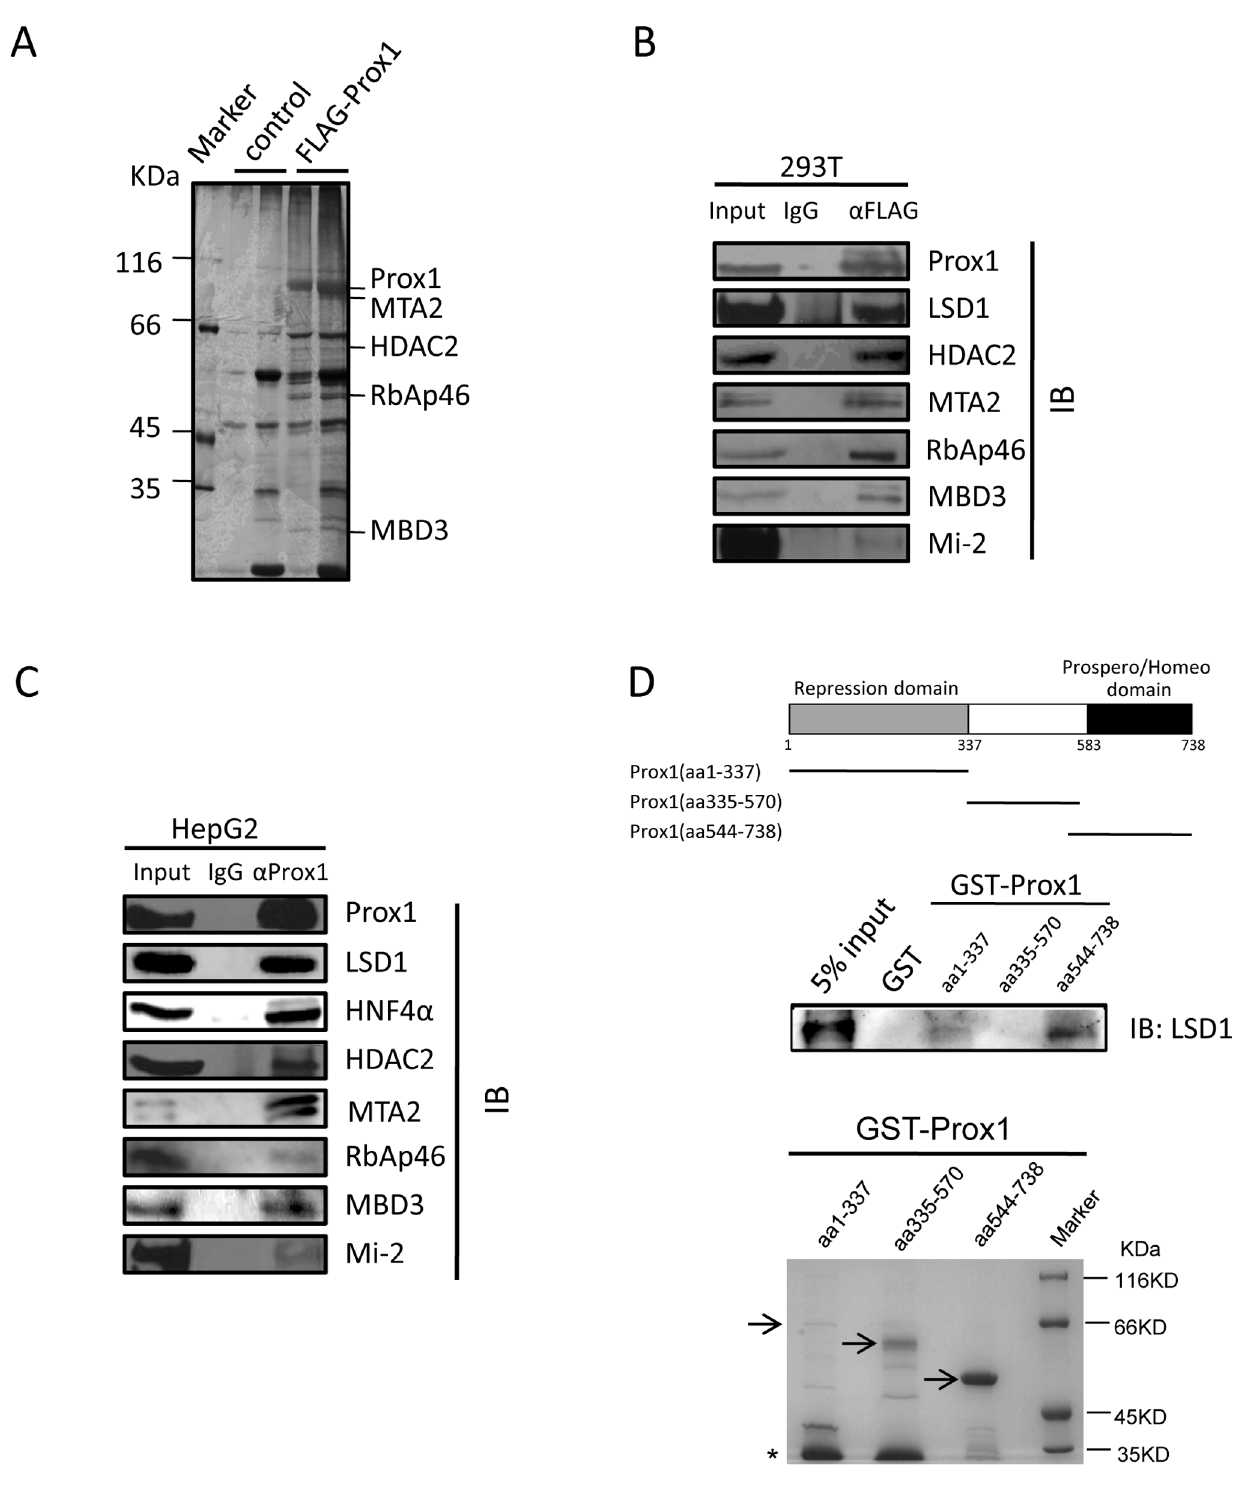
Figure 2. Prox1 is associated with LSD1/NuRD complex and directly interacts with LSD1. (A) Identification of Prox1-associated proteins using immunoprecipitation and mass spectrometry (IP-MS). HEK293T cells were transfected with plasmid expressing FLAG-tagged Prox1 and Prox1- associated proteins were immunoprecipitated using anti-FLAG monoclonal antibodies. Cells transfected with empty vector were processed in parallel as negative control. Precipitated proteins were resolved on denaturing SDS-PAGE and silver-stained. Bands exclusively found in FLAG-Prox1 samples were excised and identified using MS. Positions of bands corresponding to Prox1 and multiple LSD1/NuRD complex components are indicated. (B) Association of exogenous Prox1 with LSD1/NuRD complex in HEK293T cells. HEK293T cells transfected with plasmid expressing FLAG-tagged Prox1 or empty vector were subjected to co-immunoprecipitation assay using anti-FLAG monoclonal antibodies. Co-immunoprecipitated proteins were detected in Western blot using antibodies to LSD1/NuRD complex components as indicated. One tenth of cell lysate before co-immunoprecipitation was used as input control. (C) Association of endogenous Prox1 with LSD1/NuRD complex in HepG2 cells. HepG2 cells were subjected to co-